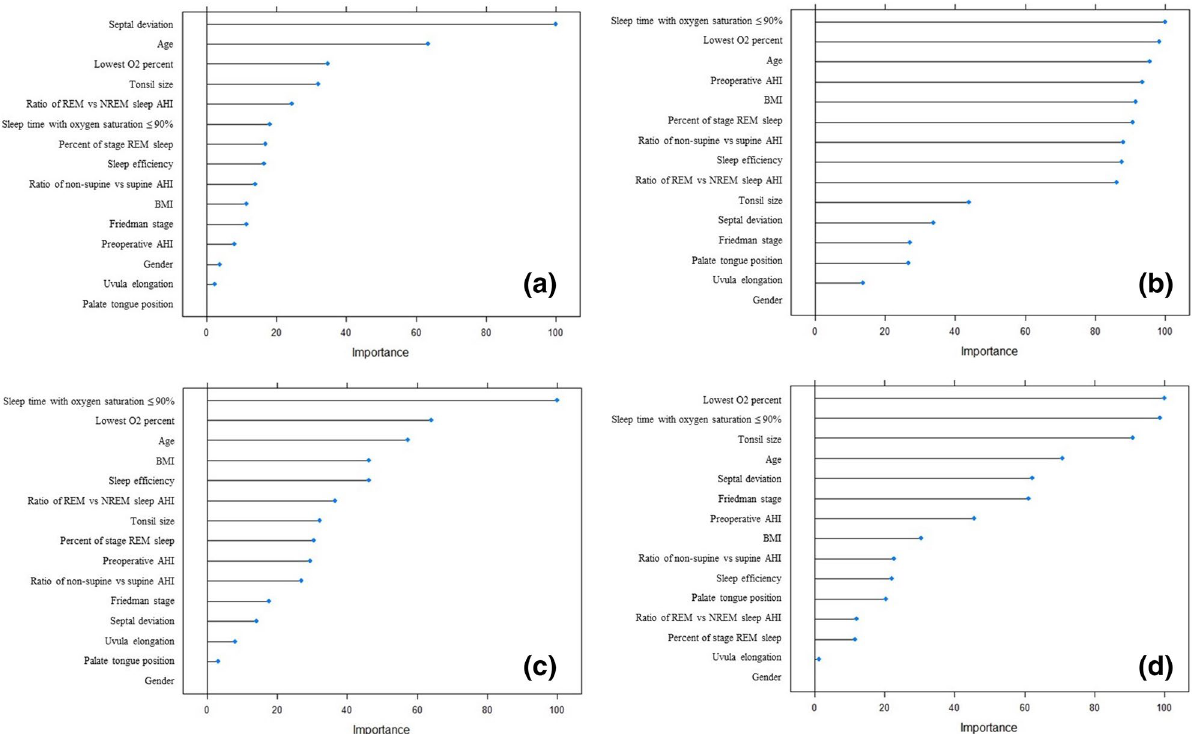
Figure 2. Importance of the variables in each model. ( a ) Logistic regression, ( b ) random forest, ( c ) gradient boosting, and ( d ) support vector machine. AHI apnea–hypopnea index, BMI Body mass index, REM rapid eye movement, NREM non-rapid eye